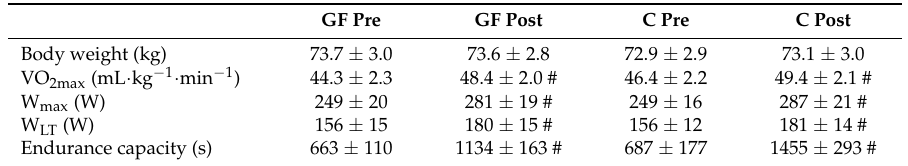
Table 1. Participants’ body weight and performance